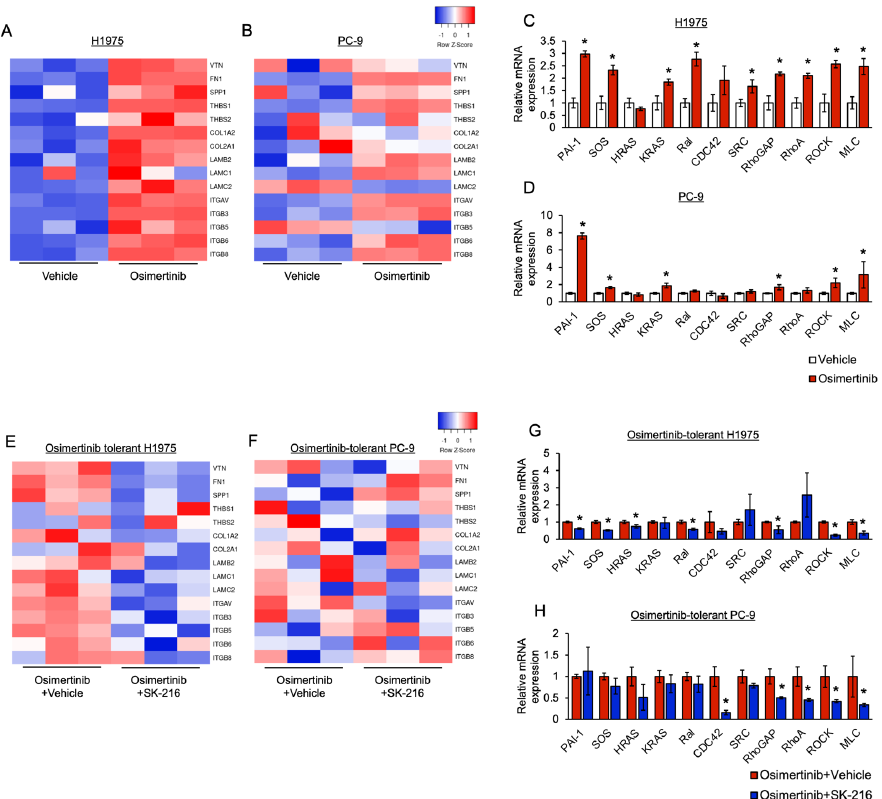
Figure 4. Involvement of PAI-1 in tolerance to EGFR-TKI via its association with integrin-initiated EMT. ( A , B ) From the microarray results, the mRNA expression levels of integrins αVβ3, αVβ6, and αVβ8 and extracellular matrix components were extracted and are shown in a heat map. In each of ( A ) H1975 and ( B ) PC-9, untreated controls were compared to osimertinib-tolerant cells. Blue represents downregulated genes; red represents upregulated genes. ( C , D ) qRT-PCR analysis of the mRNA expression of PAI-1 and integrin-initiated EMT-related genes in osimertinib-tolerant and untreated control ( C ) H1975 and ( D ) PC-9 cells. The relative expression level of each gene is shown with standard error bars (n = 4), compared with untreated control cells; * p < 0.05 (Student ’ s t -test). ( E , F ) From the microarray results, the mRNA expression levels of integrins and extracellular matrix components were extracted and are shown in a heat map. For ( E ) osimertinib-tolerant H1975 and ( F ) osimertinib-tolerant PC-9, untreated controls were compared to SK-216-treated cells. Blue represents downregulated genes; red represents upregulated genes. ( G , H ) qRT-PCR analysis of the expression of PAI-1 and integrin-initiated EMT-related genes in osimertinib-tolerant ( G ) H1975 and ( H ) PC-9 cells. Osimertinib-tolerant cells were treated with SK-216 combined with osimertinib, and mRNA expression was evaluated 48 h after SK-216 administration. The relative expression level of each gene is shown with standard error bars (n = 4); * p < 0.05 compared with cells exposed to vehicle controls (Student ’ s t -test).